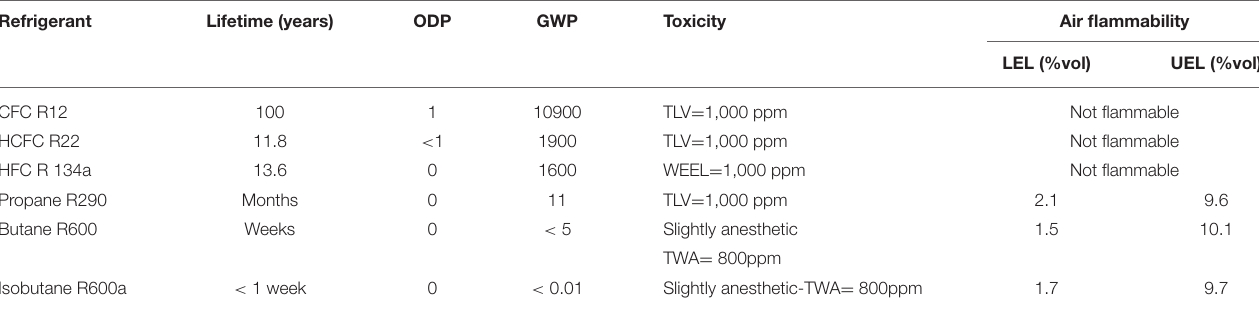
TABLE 1 | Lifetime, ozone depletion potential, halocarbon global warming potential, toxicity, and air flammability of main refrigerant fluids used in the refrigeration industry (Calm, 2000).